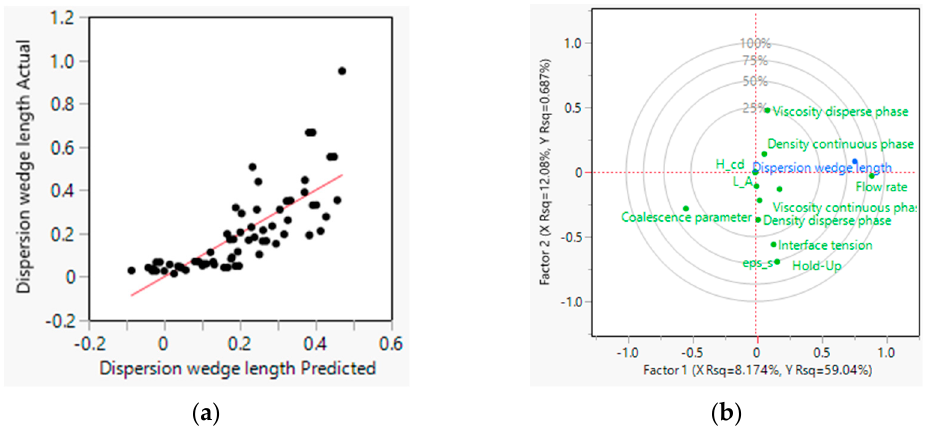
Figure 17. Plot of model quality of fit ( a ) and correlation loading plot of PLS analysis from MFAT results ( b ).